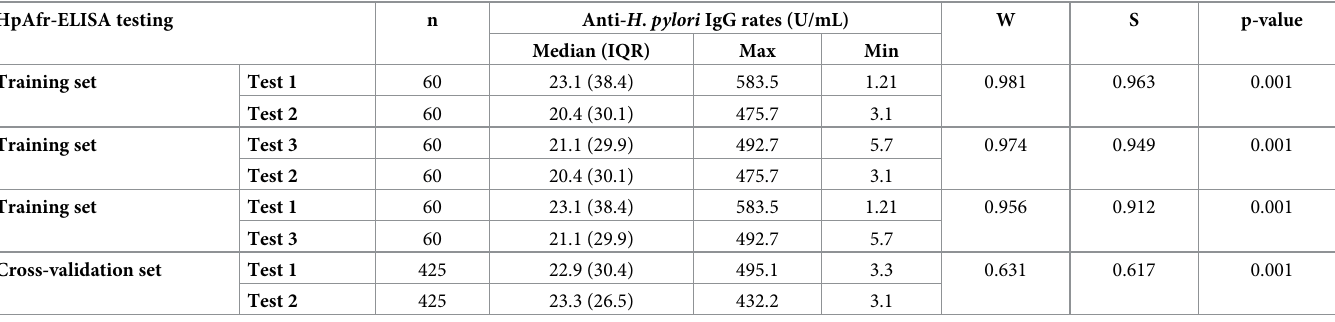
IgG levels) outcomes. The performance of the HpAfr-ELISA was similar to that reported with assays tailored for other specific populations [50–55]. The needs for adjusting ELISA for H . pylori to specific populations has been raised by consistent evidence indicating that commer- cial ELISA kits with excellent performance in populations where they are originated from, demonstrate poorer performance when used in other regions [6,9–13]. In Africa, a survey using a commercial ELISA kit optimized at high performance in the United States (US) reported a very low sensitivity (50%) in comparison to invasive tests (e.g., culture, histology, and rapid urease test) in Egypt [56]. Inconsistent outcomes noted with ELISA kits throughout different regions likely indicate varied immunogenic properties in different population which are possibly sustained by genetic variations of H . pylori from parts of the world used as a source of antigen for the kits [9–13,57]. To adapt ELISA systems to a specific regions, local H . pylori strains could be used for preparing antigens rather than foreign strains [58]. Alternatively, common antigens shared globally by strains or strains pooled from different regions could be used [57,58]. Furthermore, best cut-off-values of antibody titers should be established and vali- dated based on local epidemiology rather than values recommended by the assay’s manufac- turer [58]. In terms of antigens, whole-cell antigens covering a broad range of bacterial antigens would provide more immunogenicity than isolated antigenic components [17]. The assay developed in the current study not only used local strains but also pooled strains from most representative genetic populations of Africa and applied whole-cell antigens rather than a specific single antigen. This may explain the high performance reached with the new assay. These results indicate that the HpAfr-ELISA assay is probably a useful tool for assessing accu- rately the H . pylori infection in African setting, notably in the DRC. Obviously, H . pylori sero- logical tests detect individual who had been exposed to the pathogen including past infections Table 2. Quantitative agreement of HpAfr-ELISA outcomes at two repeated testing. HpAfr-ELISA